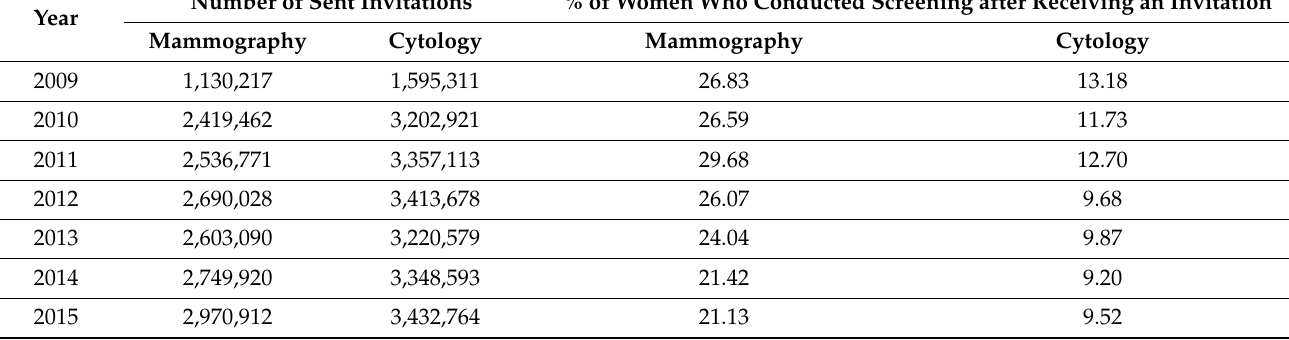
Table 3. Effectiveness of written invitations shipment in Poland in the years